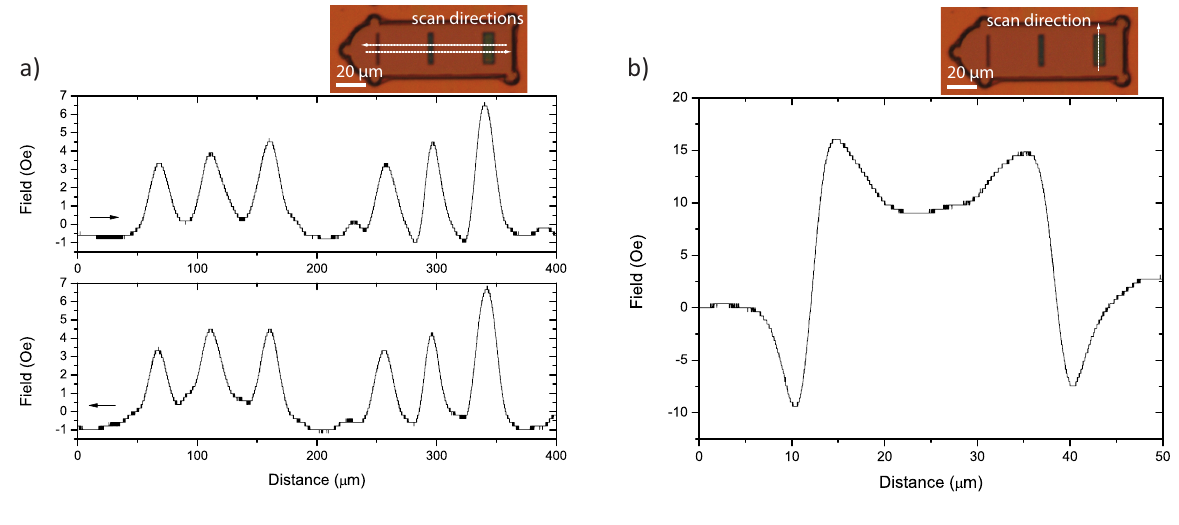
( a ) Two three-bit tags are scanned in forward (above) and reverse (below) direction, showing a high level of reproducibility. A 10 µ m/s scan speed was used with a measurement time-constant of 500 ms. The vertical distance between the sample and sensor is ≈ 5 µ m; ( b ) A single magnetic element scanned along its long axis at 10 µ m/s with a 100 ms time constant. The scan shows that the signal level increases as you travel form the centre of the element to the edge, after which the signal changes sign before dying away. The sensitive axis the TMR sensor for ( a ) and ( b ) points along the length of the magnetic